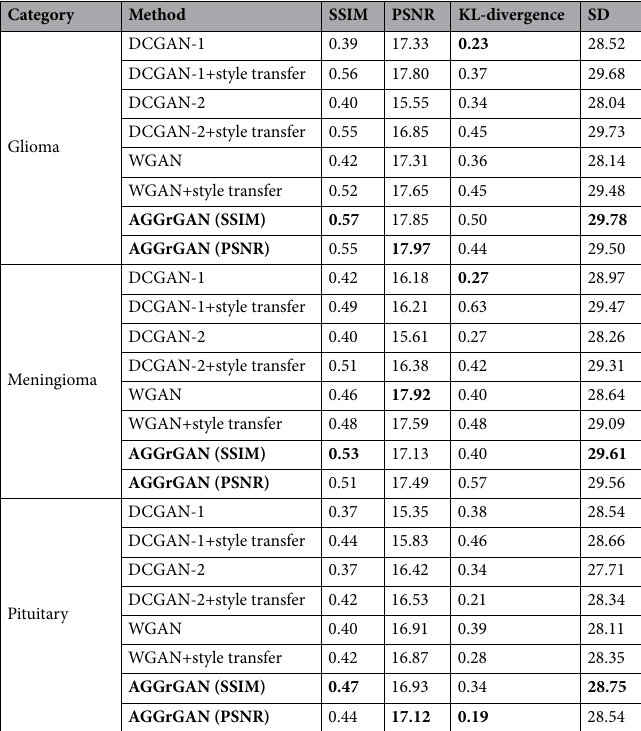
Table 1. Performance of the base GAN models along with AGGrGAN applied on the brain tumor dataset. Values in bold signify that they are—(i) the metric-wise best value obtained for the corresponding class for Tables 1, 2, 3, 4 and (ii) case-wise best performance obtained for a particular